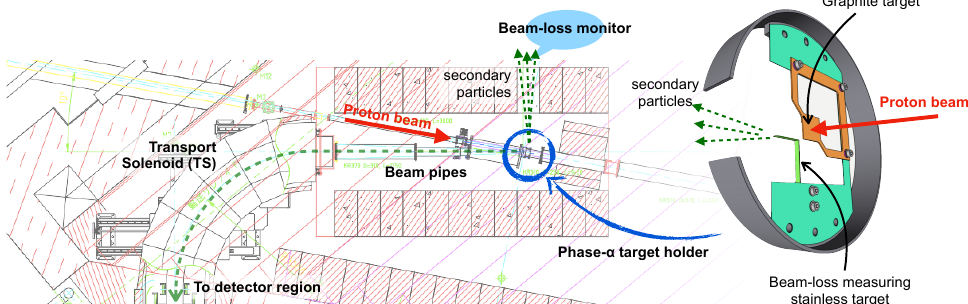
Figure 10. Setup for the first beam commissioning phase (Phase- α ). A picture of the production target holder is also shown on the